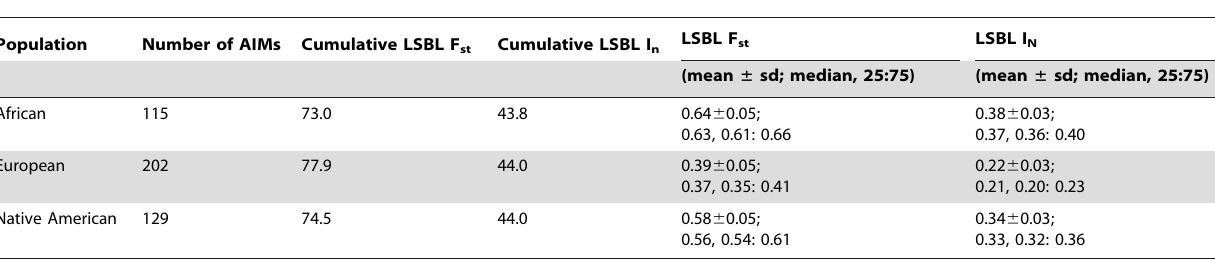
Table 1. Characteristics of the AIMs